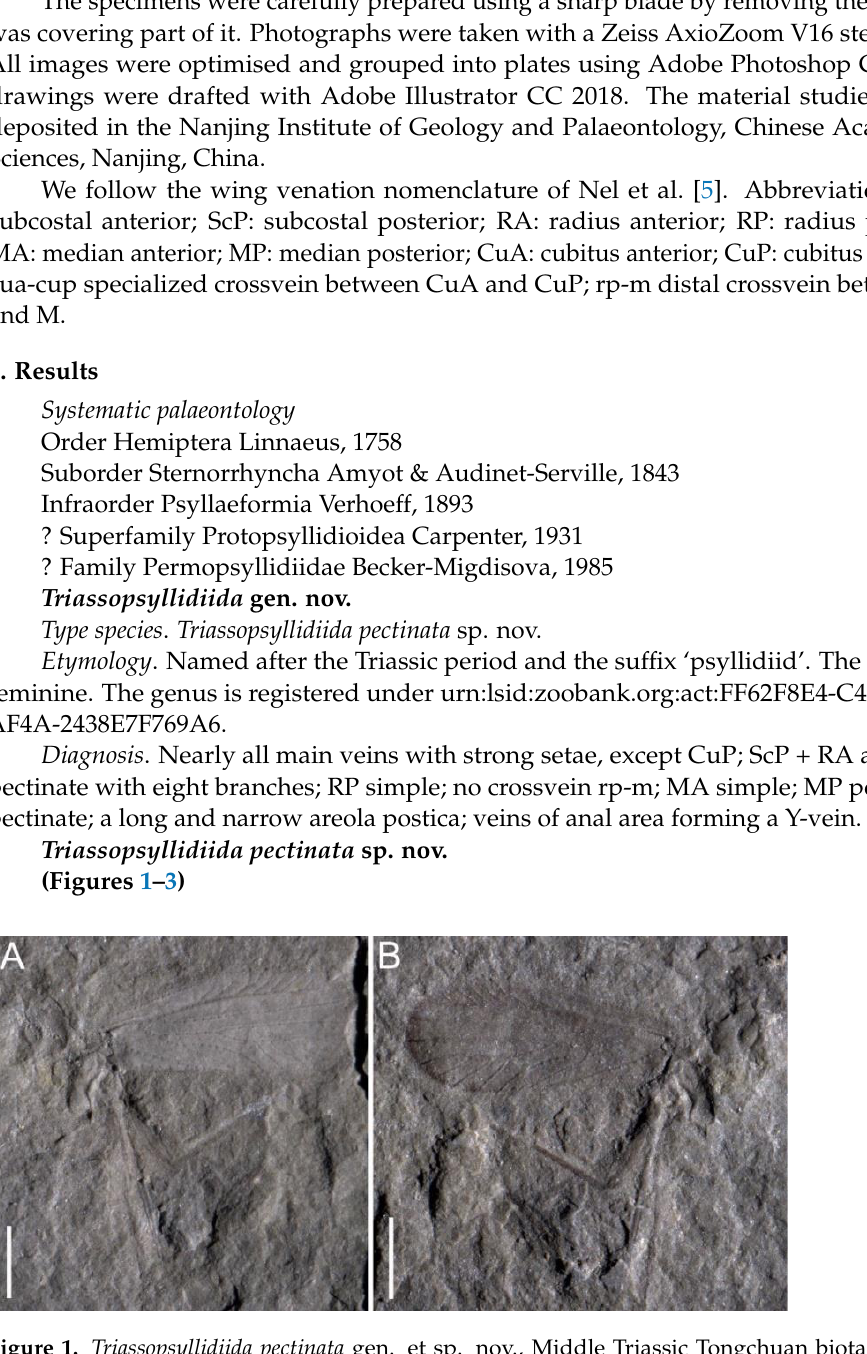
Figure 1. Triassopsyllidiida pectinata gen. et sp. nov., Middle Triassic Tongchuan biota, holotype NIGP180297, photographs of general habitus. ( A ) part; ( B ) counterpart. Scale bars: 1